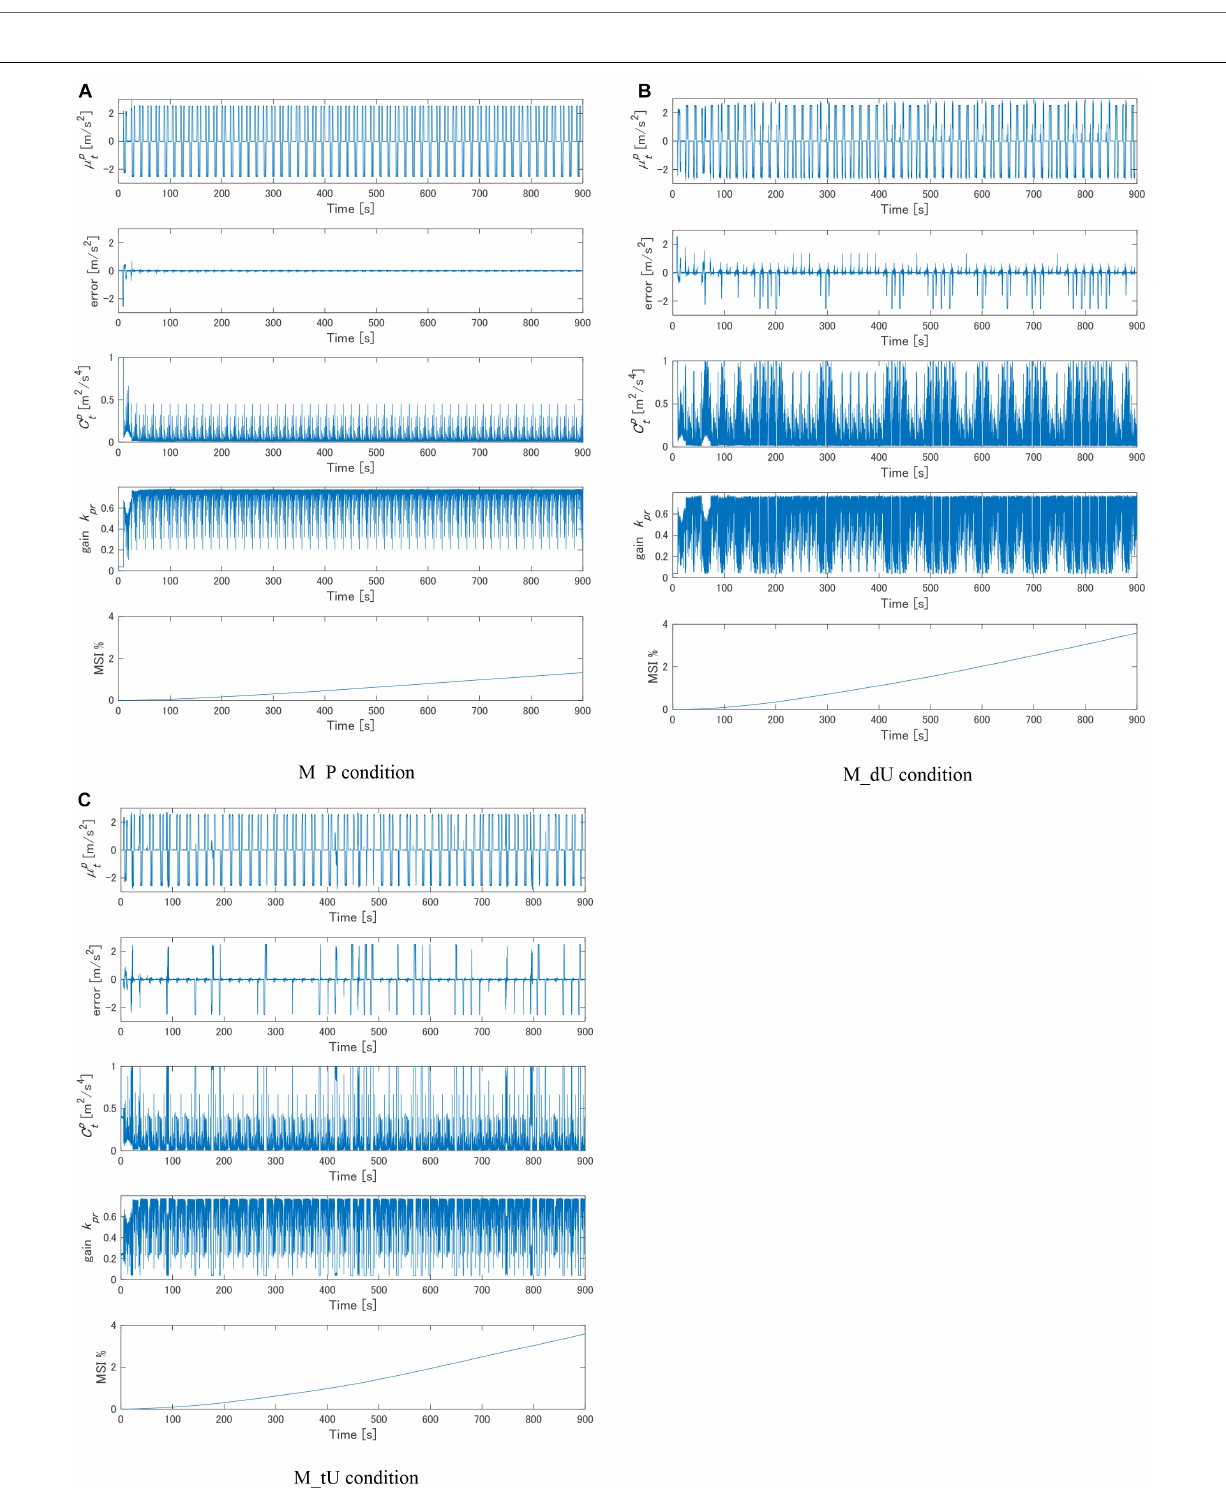
FIGURE 5 | Temporal histories of representative variables with the proposed model for every motion profile condition: (A) M_P, (B) M_dU, and (C) M_tU. The scalars p µ p t and C t denote the mean and variance of acceleration predicted by the proposed method, respectively. The error depicted on the second row was calculated as µ p − α t : the discrepancy between the predicted mean and the given acceleration of the exogenous disturbance. The gain k pr was determined by Eq. (20) according t to C p t . The predicted MSI by the proposed model is shown as the output of the